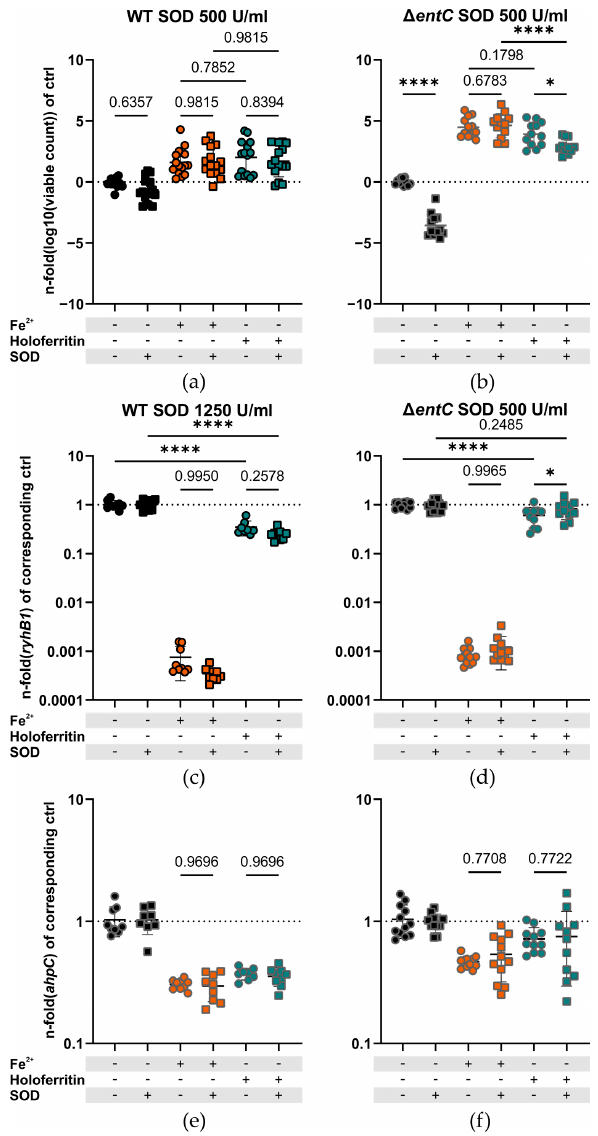
Figure 4. Iron-dependent growth of ( a ) WT S. Tm (N = 15, n = 5) and ( b ) the ∆ entC strain with or without SOD, depicted as squares and circles, respectively (N = 12, n = 4). Fold change in RyhB1 sncRNA expression normalized to the mean of the corresponding iron-free control of ( c ) WT S. Tm (N = 9, n = 3) and ( d ) the ∆ entC strain upon different iron sources with and without SOD (N = 12, n = 4). Fold change in ahpC expression normalized to the mean of the corresponding iron-free control of ( e ) WT S. Tm (N = 9, n = 3) and ( f ) the ∆ entC strain upon different iron sources with and without SOD (N = 12, n = 4). ( c , e ) In the WT a higher concentration of SOD was used in order to ensure complete dismutation of O 2- to assess a possible involvement of the catalytic mechanism with strong iron(III) ligands [57]. Cultures were incubated at 5% O 2 5% CO 2 , 37 ◦ C and 200 RPM. Growth data were logarithmized and then normalized to the corresponding control without any supplement. Expression data were normalized to their corresponding controls: no supplement (circles) or SOD (squares). Gene expression was normalized using the ∆∆ ct method using the 16S ribosomal RNA ( 16S rRNA) and DNA-dependent RNA polymerase ( rpoB ) mRNA as reference transcripts. Graphs are depicted as mean ± SD. For statistical analysis, one-way ANOVA ( a – f ) corrected for multiple comparisons when the Holm-Sidak post hoc test was used (*: p < 0.05, ****: p < 0.0001, numbers indicate a non-significant p -value > 0.05). N: number of biological